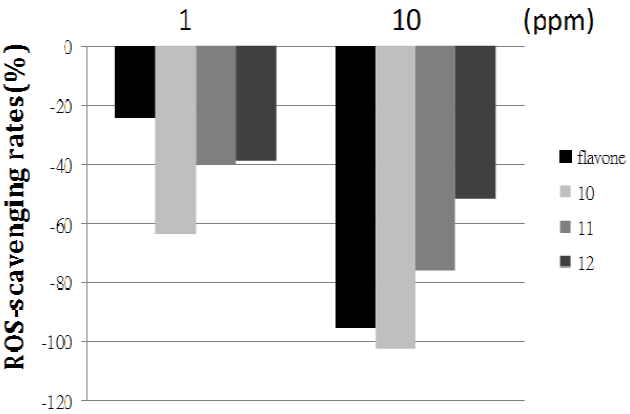
Figure 1. Comparison of ROS-scavenging ability of flavone and 3 ′ ,4 ′ -diaminoflavones 10 , 11 , and 12